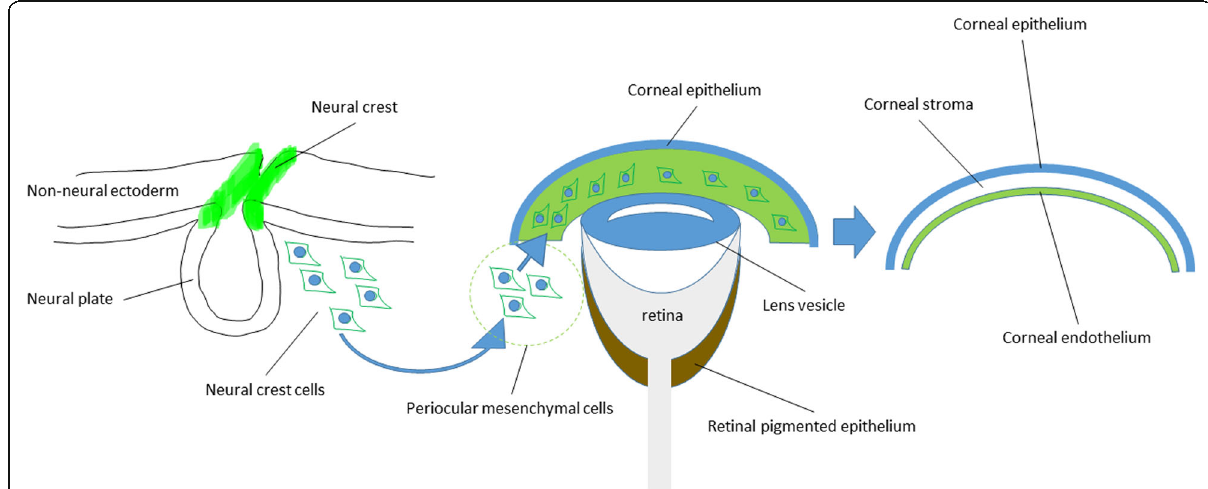
Fig. 1 Schema of corneal endothelium development. Neural crest cells begin to migrate from neural plate border with the endothelial- mesenchymal transition and reach periocular lesion. Next, neural crest cells (or periocular mesenchymal cells) migrate beneath corneal epithelium and mature to be corneal endothelium. This process is thought as the mesenchymal-endothelial